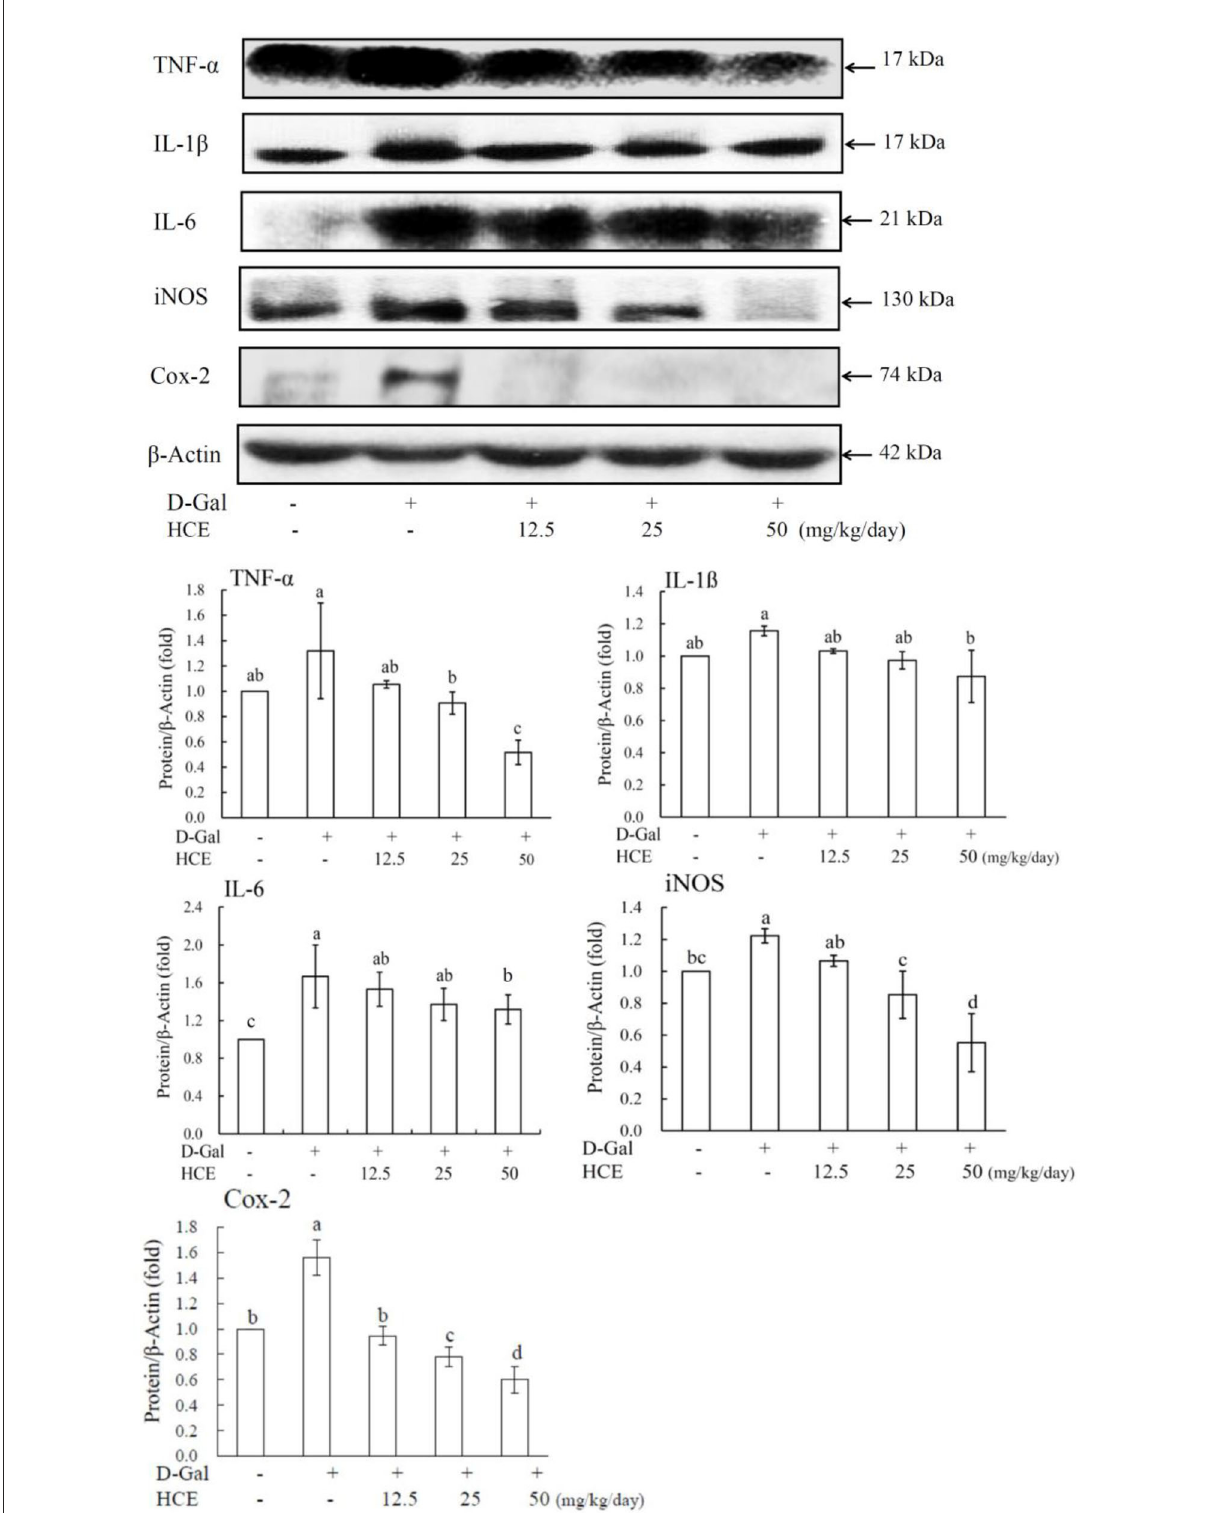
FIGURE2 Effects of herbal chicken essence (HCE) on TNF- α , IL-1 β , IL-6, iNOS, and Cox-2 production in the liver tissue of D-galactose-induced aging mice. β -Actin was used as a loading control. Values are expressed as means ± SD ( n = 6). The bar having the same letter was not significantly different at P < 0.05 as analyzed by Duncan’s multiple range